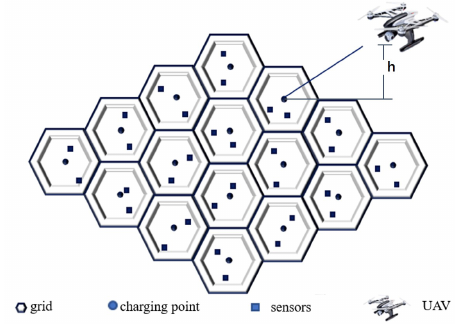
Figure 1. System